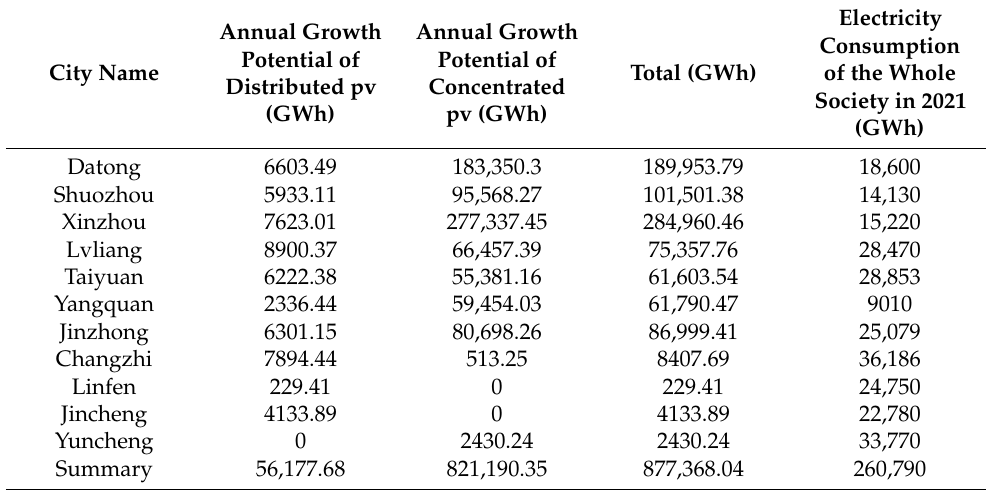
Table 8. Photovoltaic power generation potential statistics of cities in Shanxi